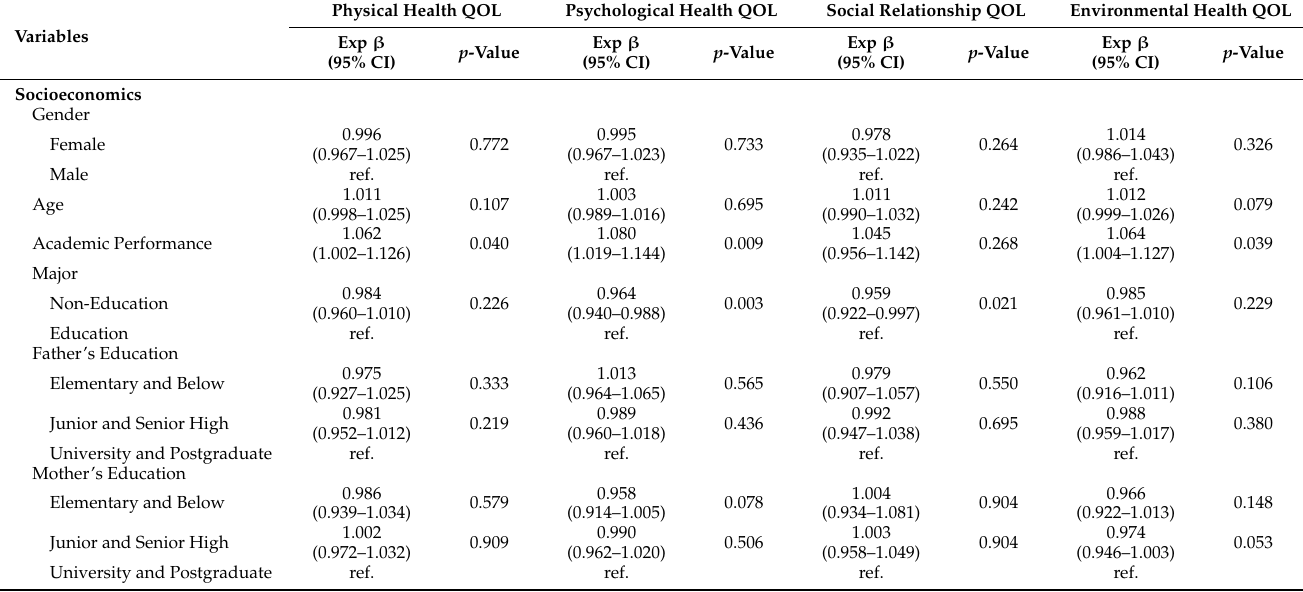
Table 3. Multivariate GLMs gamma log-link for the four domains of QOLs with CHL in addition to socioeconomic determinants, HBs, and